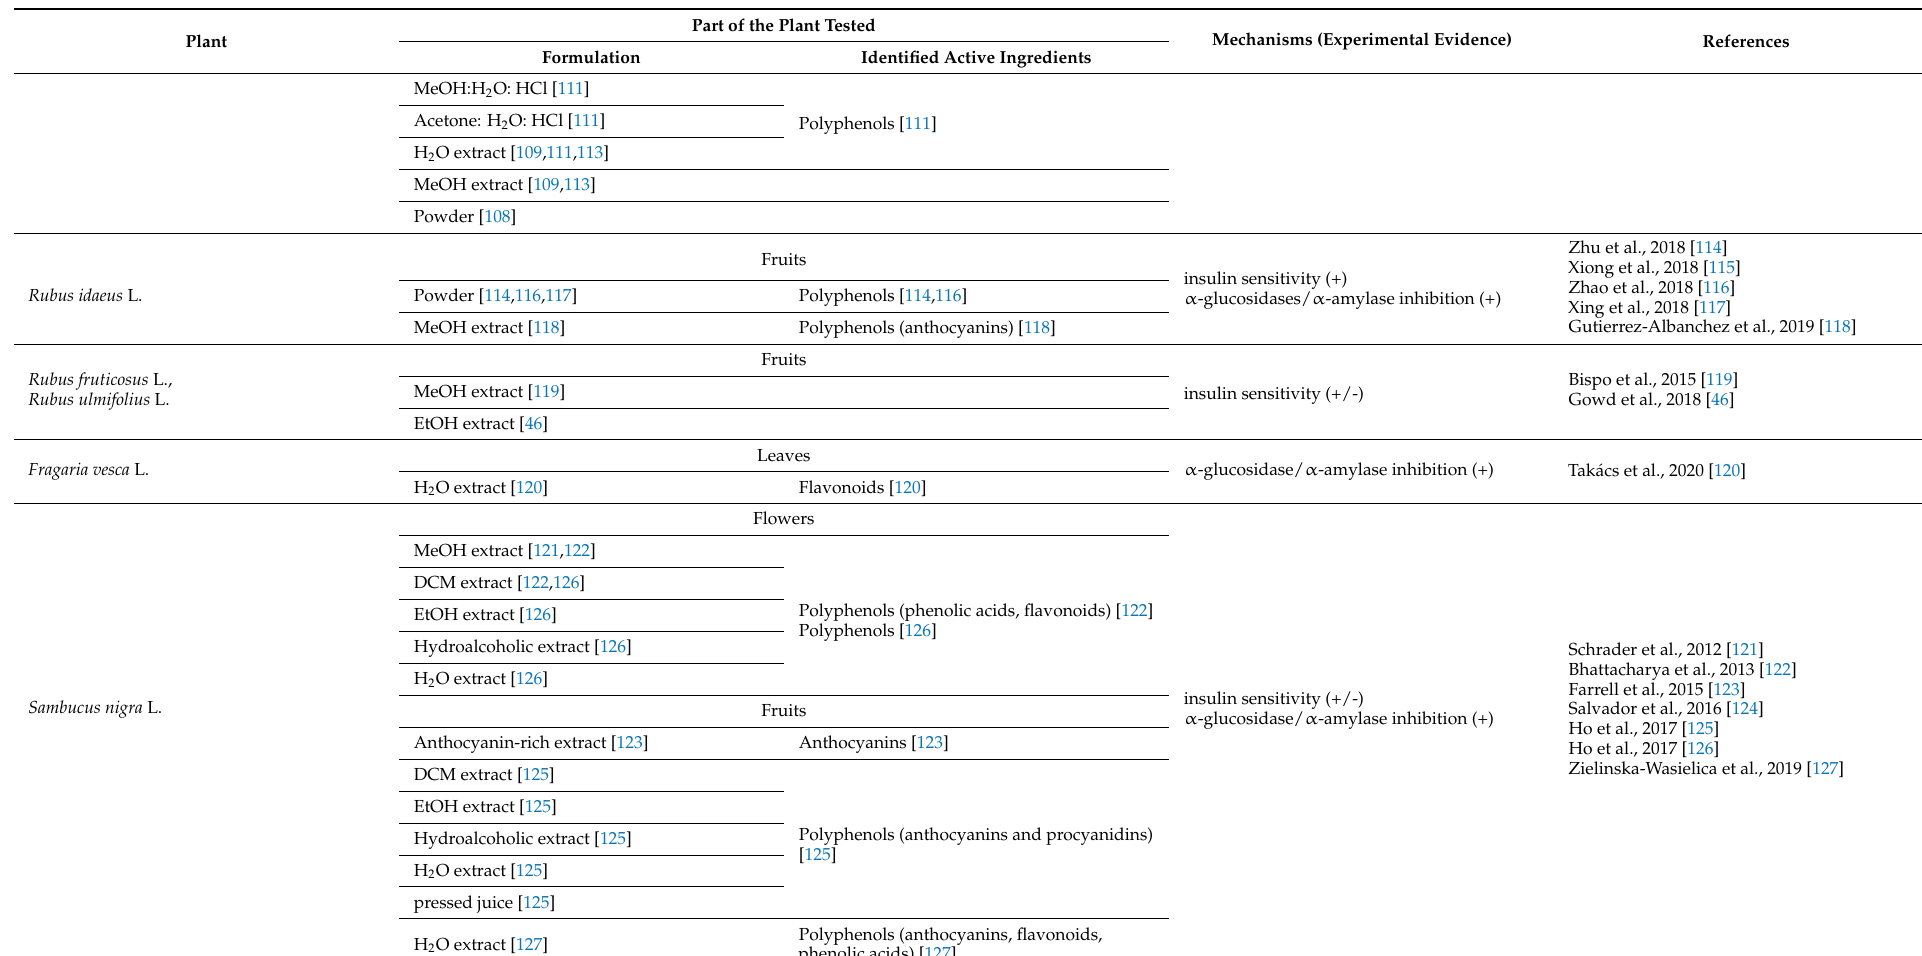
Table 2. Plants used in the Occitan valleys of the Piedmont Alps: potential direct anti-diabetic mechanisms (experimental evidence between 2011 and 2021).